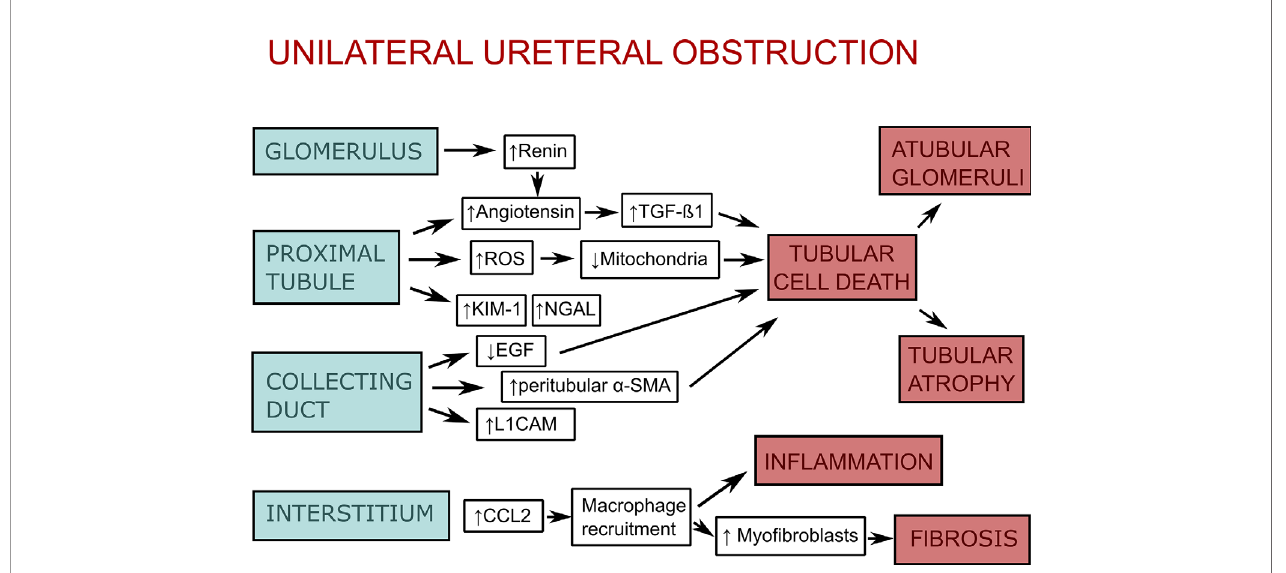
FIGURE 1 | Scheme of the pathophysiology of unilateral ureteral obstruction (UUO). As a response to unilateral ureteral obstruction the glomerulus increases vascular renin production along with activation of the renin-angiotensin system, which leads to stimulation of transforming growth factor- b 1 (TGF-1 b ). The proximal tubular epithelium activates the renin-angiotensin system as well. Additionally, it increases production of reactive oxygen species (ROS), which impair mitochondrial function, as well as kidney injury molecule-1 (KIM-1) and neutrophil gelatinase-associated lipocalin (NGAL). Collecting duct injury leads to downregulation of epidermal growth factor (EGF) and upregulation of peritubular mesenchymal collars that express a -smooth muscle actin ( a -SMA) and L1 cell adhesion molecule (L1CAM). Injury of glomeruli, proximal tubule, and collecting duct lead to tubular cell death (apoptosis, necrosis, and necroptosis), which itself leads to atubular glomeruli and tubular atrophy. In the interstitium, there is an upregulation of chemokines (CCL-2, CCL-5) and adhesion molecules as an response to obstruction. This leads to macrophage recruitment, interstitial in fl ammation, and stimulation of myo fi broblast proliferation, which causes fi brosis. The fi gure is adapted from